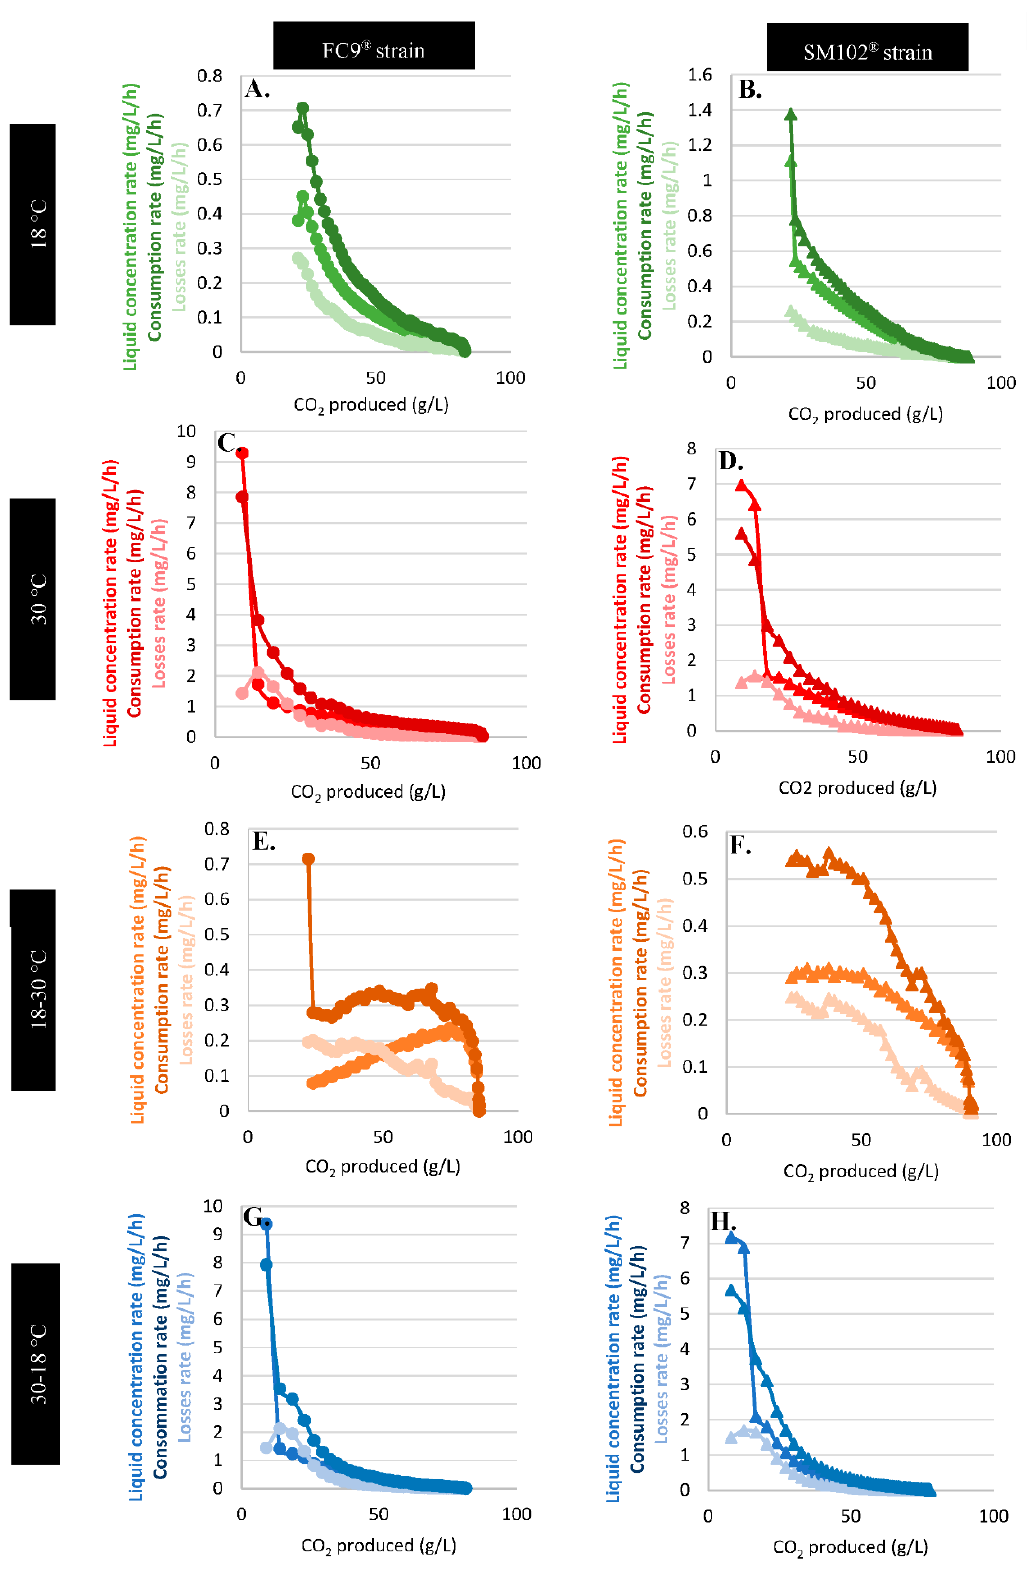
Figure 7. The value of online monitoring, making it possible to produce and visualize complete production balances for the two strains FC9 ® ( A , C , E , G ) and SM102 ® ( B , D , F , H ) at 18 °C ( A , B ), 30 °C ( C , D ), 18 – 30 °C ( E , F ) and 30 – 18 °C ( G , H ). Assessments carried out during the stationary phase: the decrease in the acetaldehyde concentration was demonstrated by the rate of decrease in the liquid phase (mg/L/h), the rate of physical losses (mg/L/h) and the rate of consumption (mg/L/h).